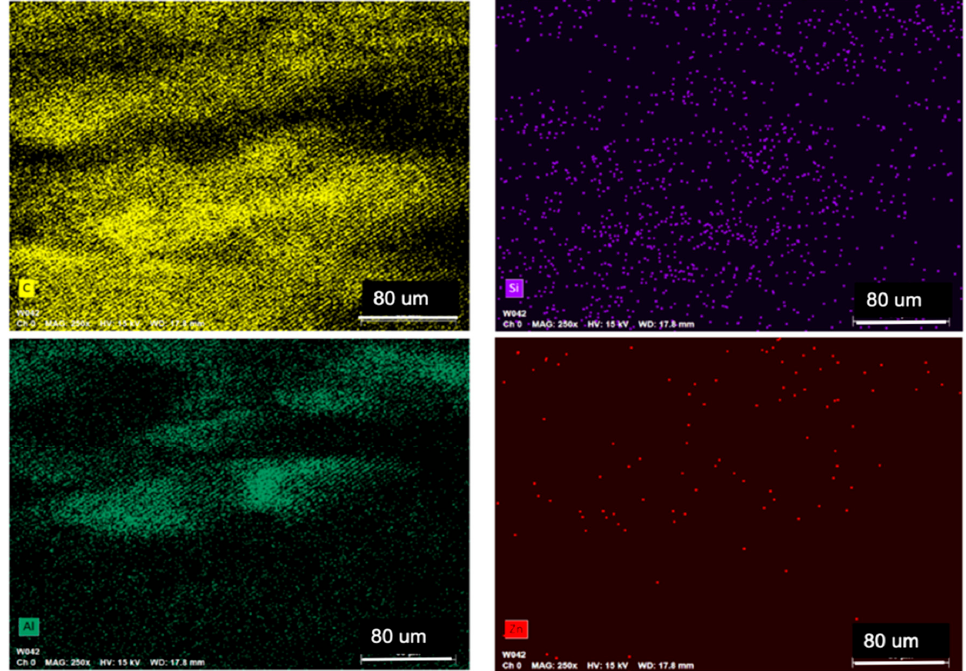
Figure 4. Energy dispersive spectrometer (EDS) analysis of polylactic acid and halloysite